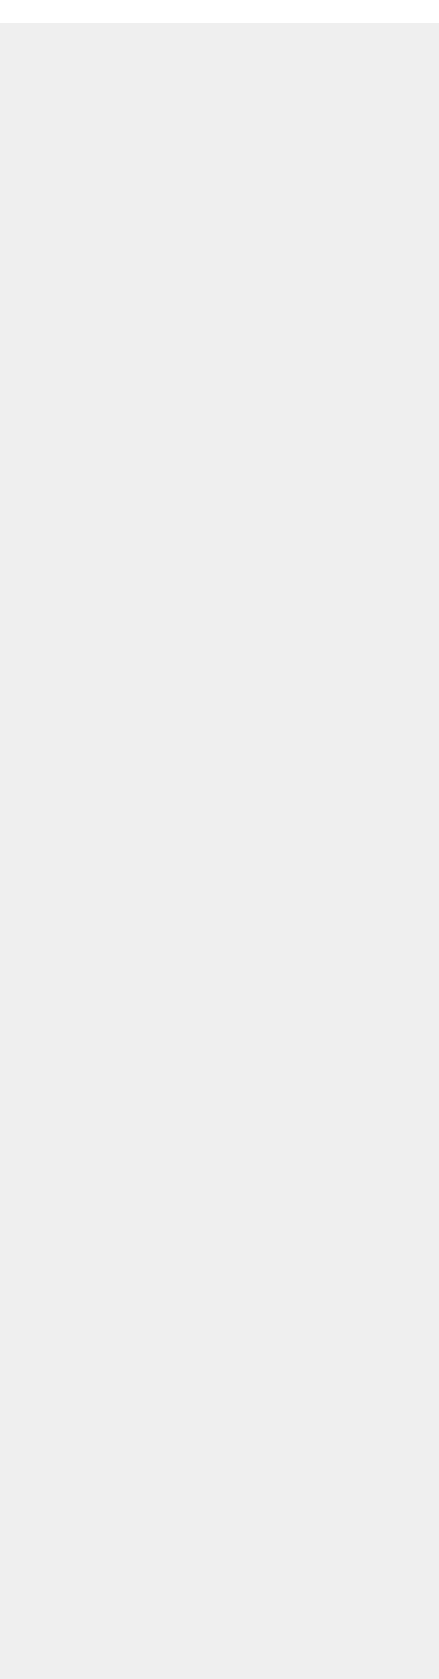
Figure 11 Chronic obstructive pulmonary disease. Correlation between panlobular emphysema ( A/B ) and pulmonary hypoperfusion ( C/D )